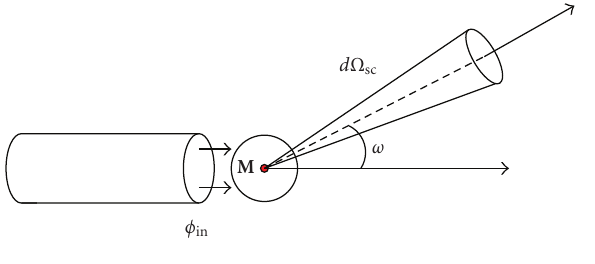
Figure 2: Compton scattering di ff erential cross-section.